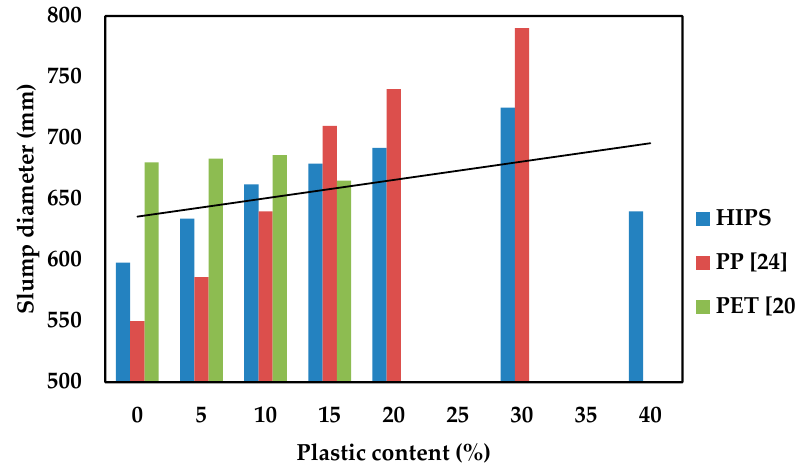
Buildings 2019 , 9 , x FOR PEER REVIEW Figure 3. Slump flow variations with different plastic replacements for sand. Figure 3. Slump flow variations with different plastic replacements for sand. 202